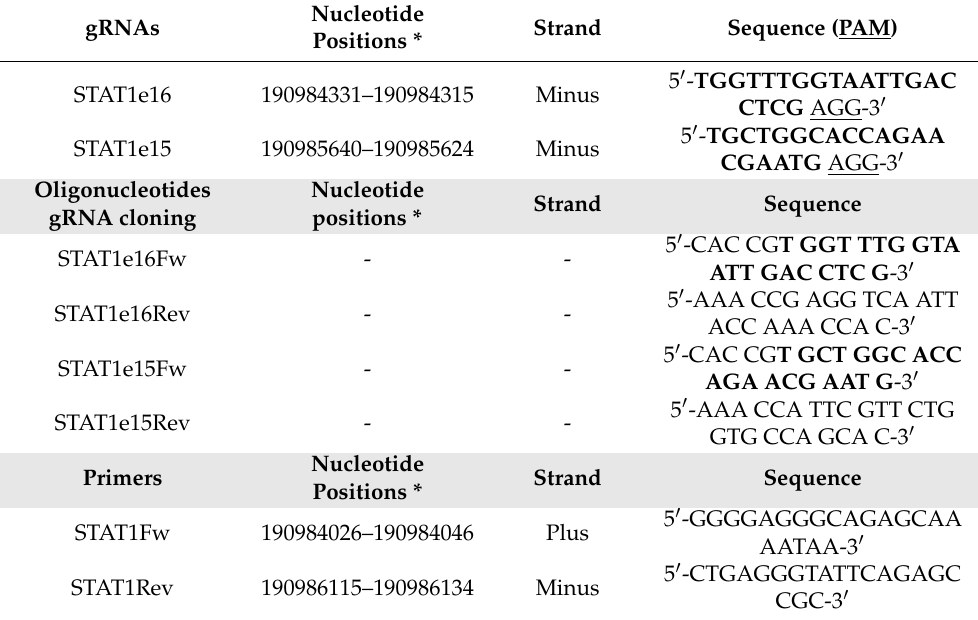
Table 1. STAT1 e16 and e15 single guide RNAs sequence and primer designed for excision